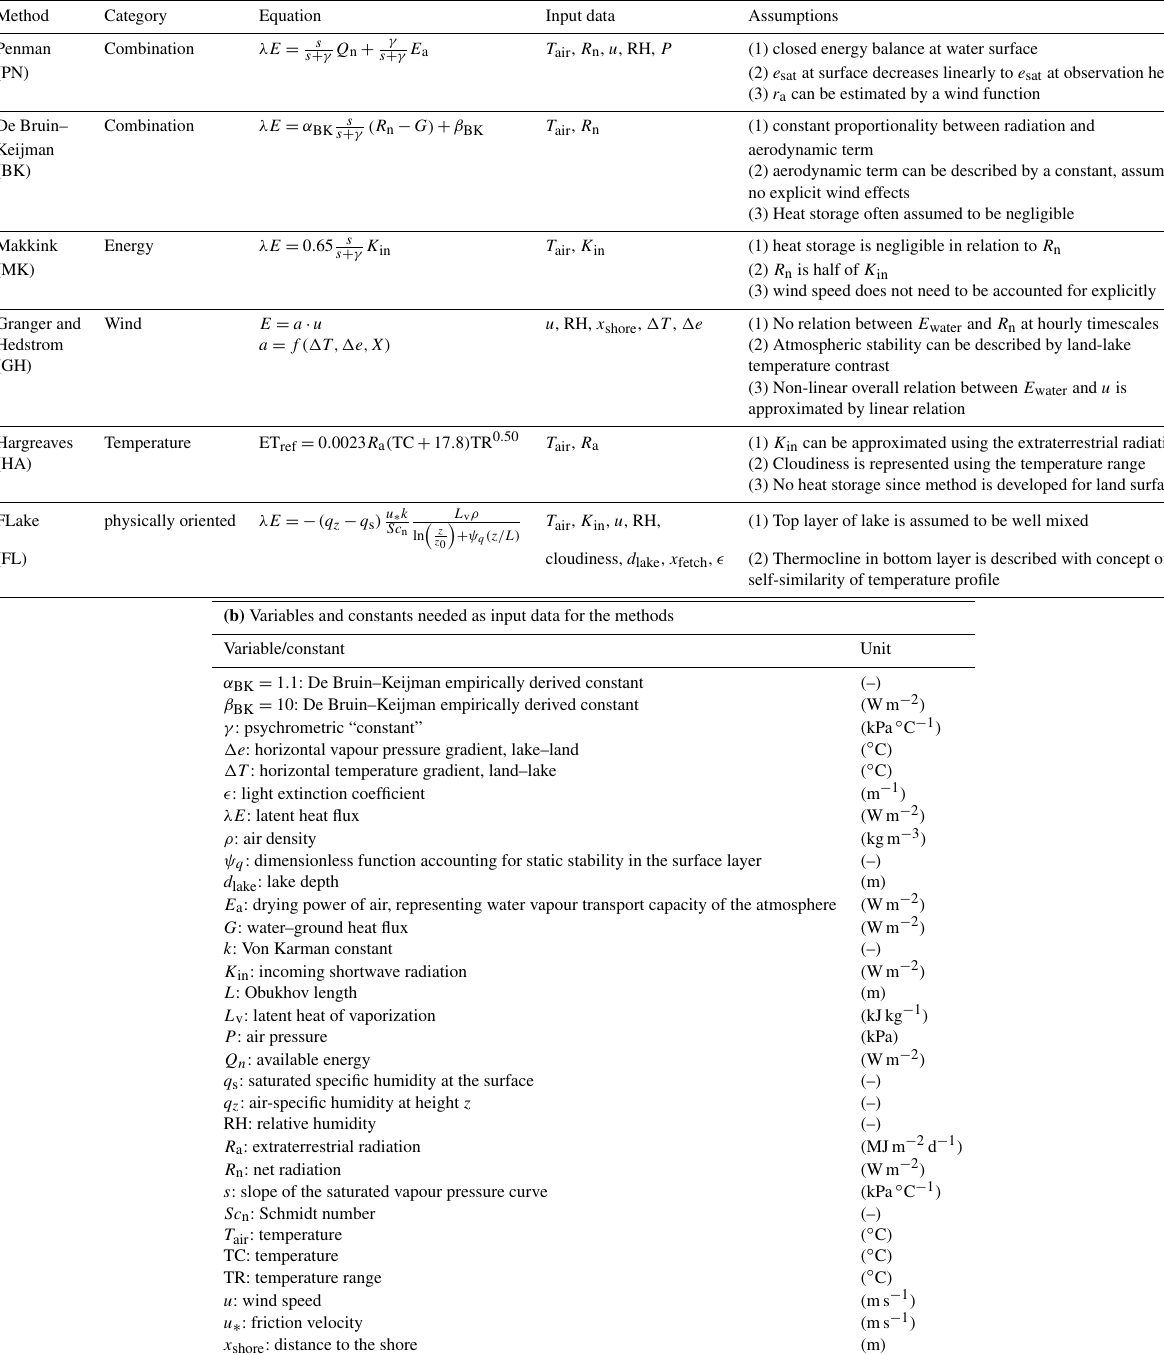
Table A1. Evaporation methods further